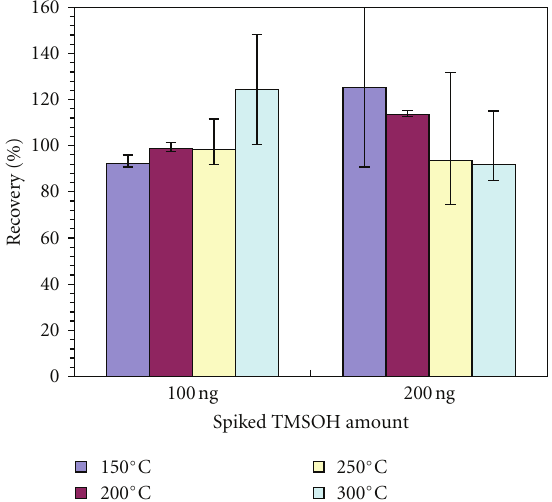
Figure 2: TMSOH abundances at di ff erent thermal desorption temperatures. Error bars show minimum and maximum